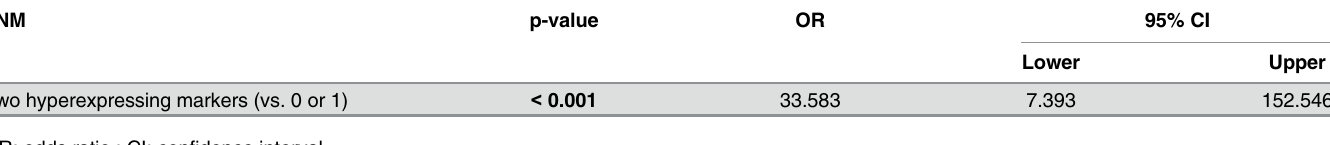
Two hyperexpressing markers (vs. 0 or